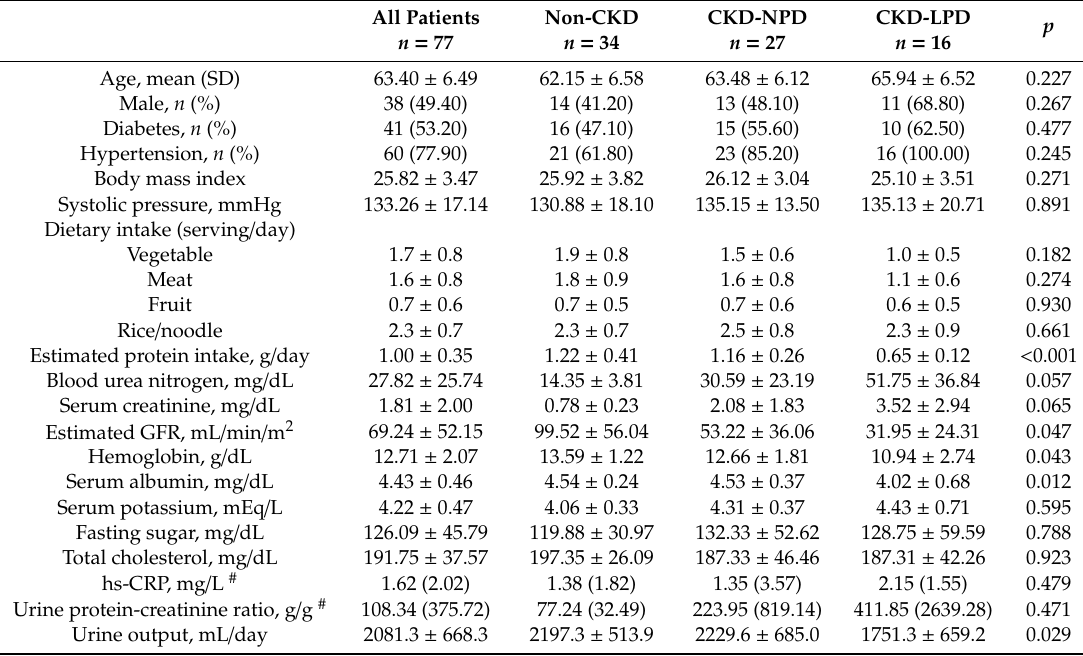
Table 1. Baseline characteristics of study population ( n =